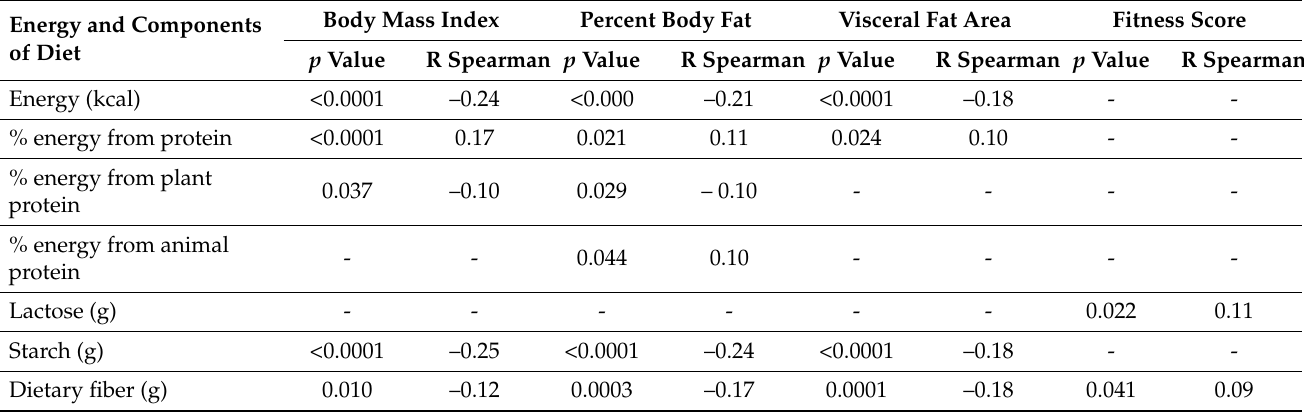
Figure 1. Percentage of women depending on the value of the body mass index (BMI), percent body fat (PBF), and visceral fat area (VFA). Table 6. Correlation between parameters of the body composition and consumed energy and components of diet ( n =